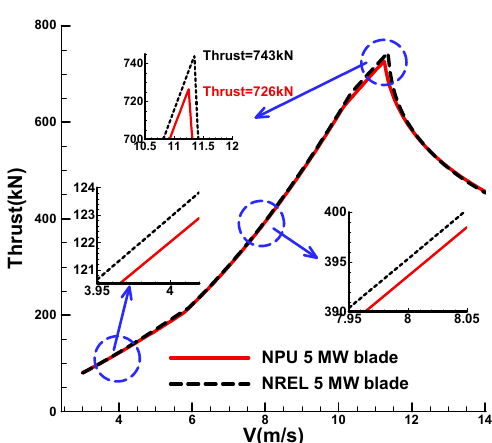
Figure 24. Comparison of thrust–wind speed for the NPU and NREL 5 MW blades.